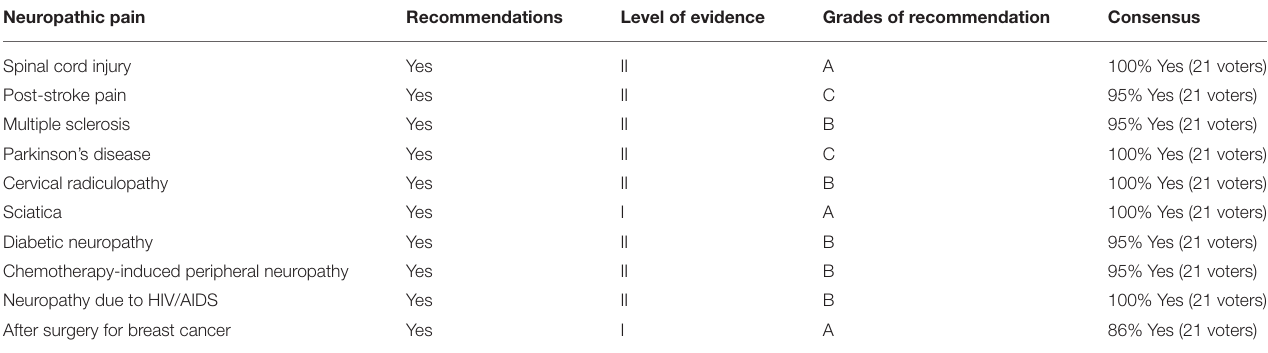
TABLE 7 | Recommendation summary of exercise for neuropathic pain